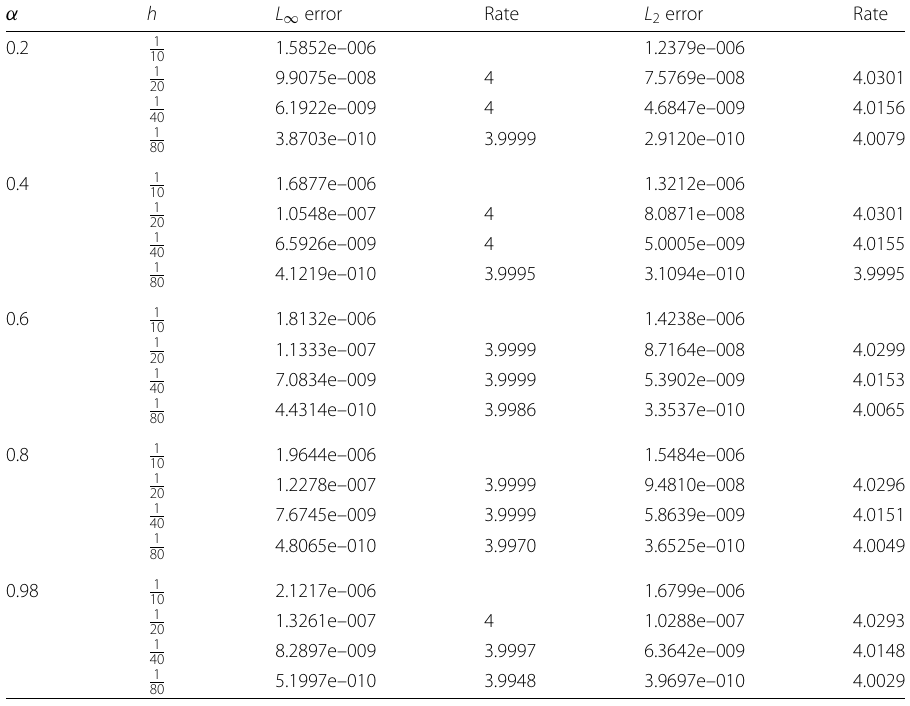
Table 8 The L ∞ , L 2 errors and spatial convergence orders with τ = 1/1000 for Example 4 α h